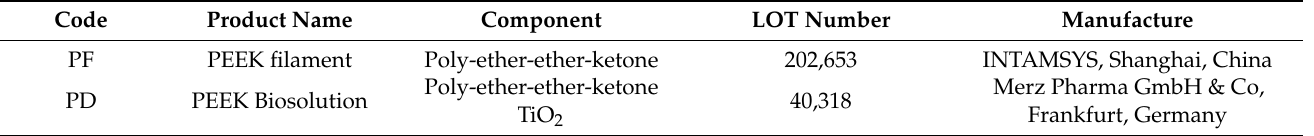
Table 1. Composite resins used in this study.